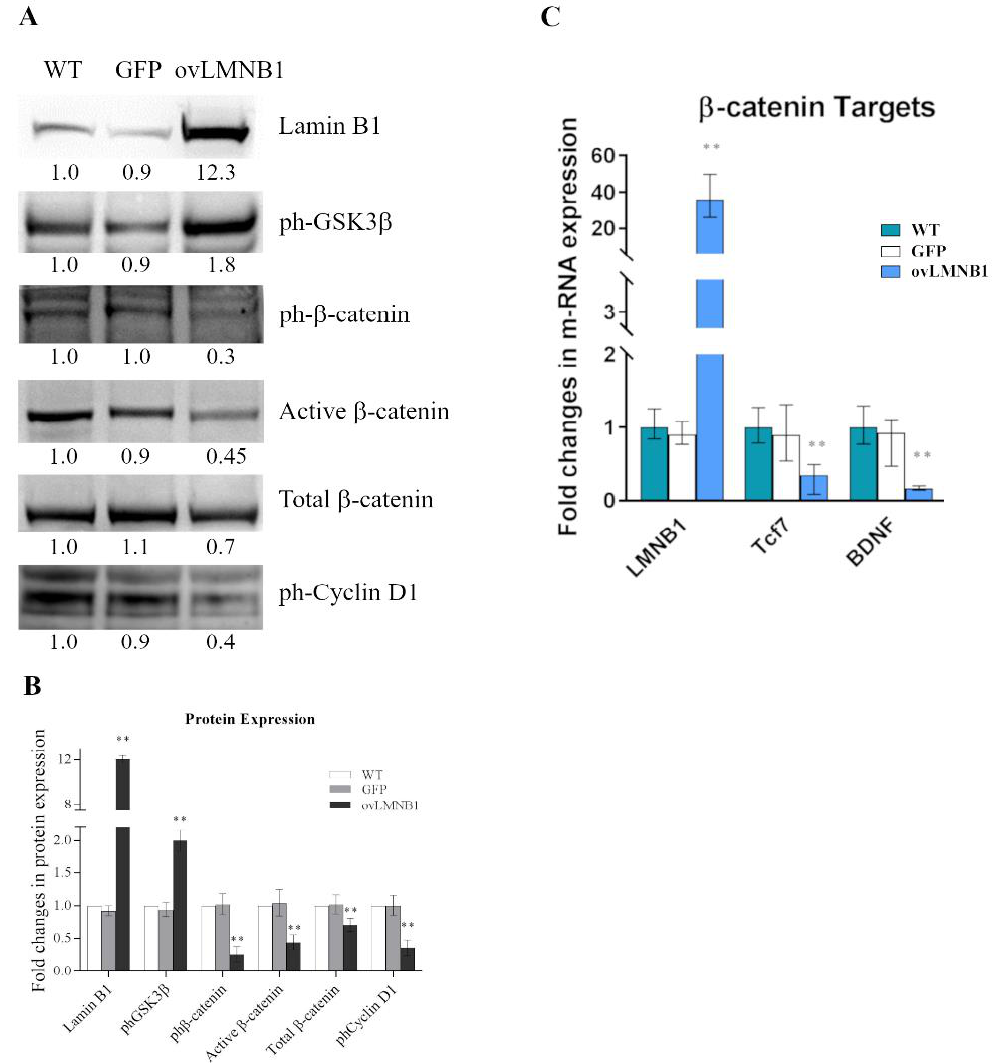
Figure 2. Lamin B1 overexpression affects the activity of GSK3β and the phosphorylation of its targets: ( A ): The expression and the phosphorylation of targets of GSK3β were evaluated in U87-MG cells 96 h after transduction. Lamin B1-overexpressing cells (ovLMNB1) were compared to wild type (WT) and mock-transduced (GFP) samples. The expression or phosphorylation of the denoted proteins was assayed. Samples were normalized by Total Protein Normalization and compared to WT sample. Western blot results are representative of five independent experiments. ( B ): Quantitative analysis of protein expression, wild type cells (WT) were used as reference sample. ** denotes p < 0.01 vs. corresponding mock-transduced sample (GFP). ( C ): The expression of β -catenin targets was tested in cells transduced to overexpress Lamin B1 (ovLMNB1) and compared to wild type (WT) and mock-transduced (GFP) cells. Cells were tested after 48 h of puromycin selection, i.e., 96 h after transduction overall. The panel shows the evaluation of mRNA levels by real-time PCR. GAPDH was used as a housekeeping gene and wild type cells as a reference sample. All the analyses are from five independent experiments, with ** p < 0.01 vs. corresponding mock-transduced sample